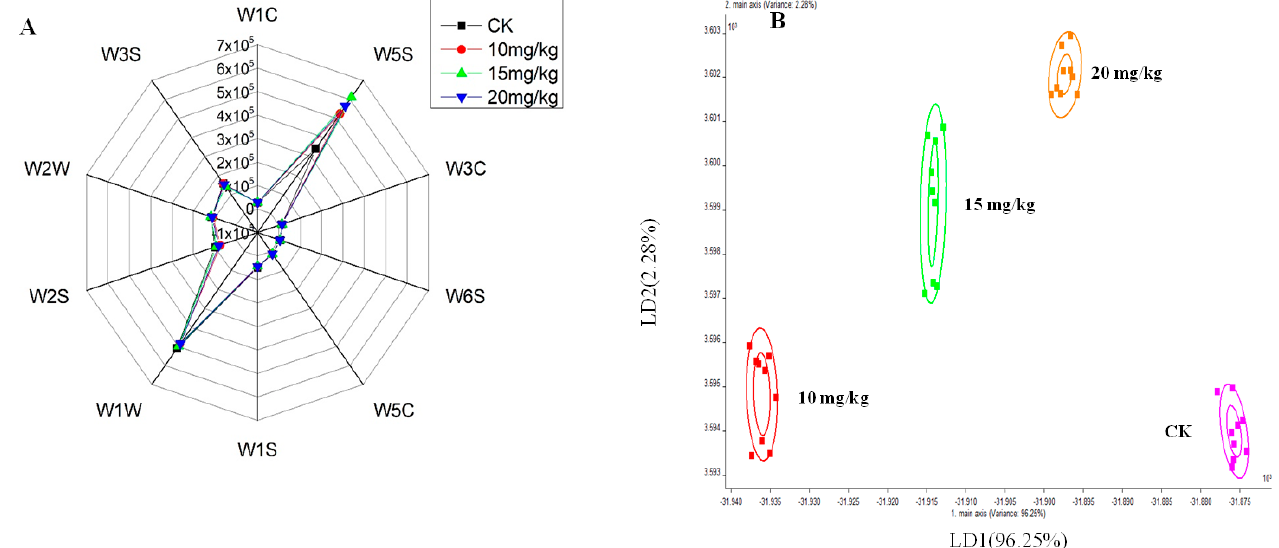
Figure 1. ( A ) Radar chart and ( B ) linear discriminant analysis (LDA) of fresh oriental melon after forchlorfenuron application obtained by E-nose measurement. CK: pollination group; 10 mg/kg: low-dose forchlorfenuron application group; 15 mg/kg: mid-dose forchlorfenuron application group; 20 mg/kg: high-dose forchlorfenuron application group.